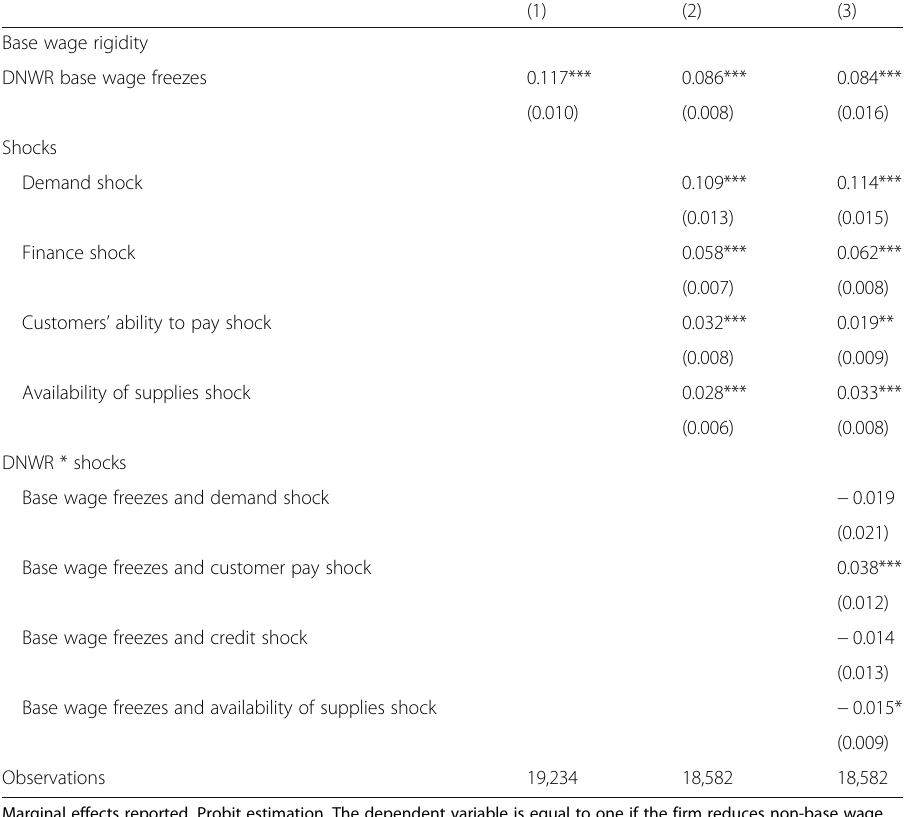
Table 5 Relationship between cuts in non-base wage components and base wage